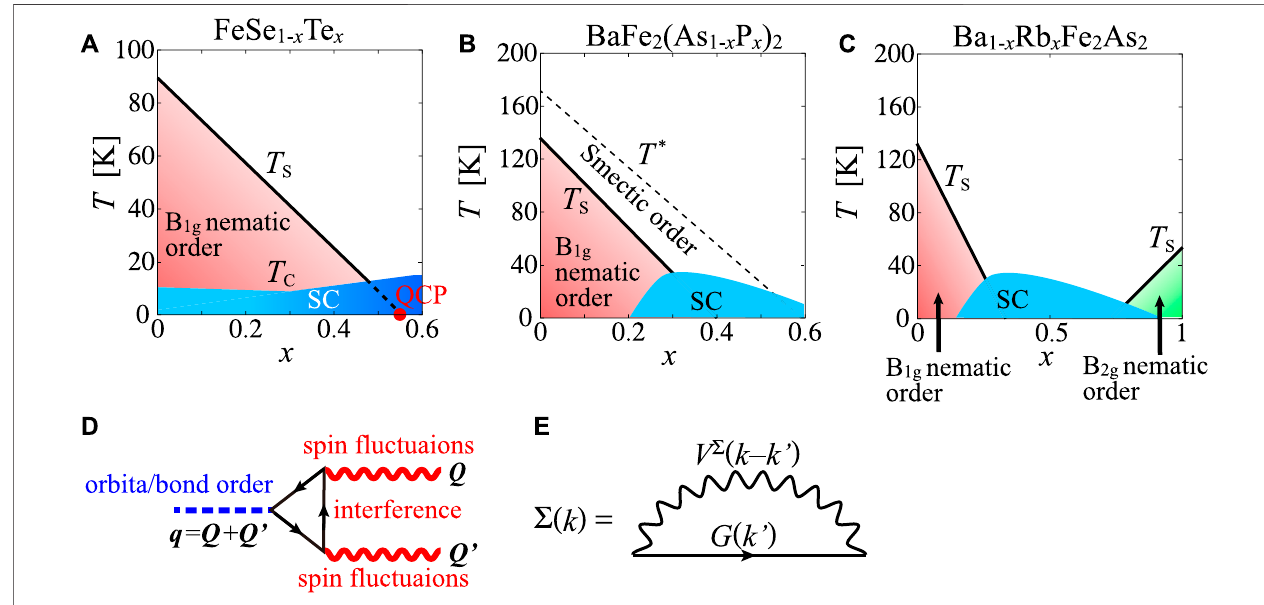
FIGURE 1 | (A) Schematic x - T phase diagram of FeSe 1 − x Te x , where T S decreases with x , and T c becomes maximum near the nematic QCP. (B) Schematic x - T phase diagram of BaFe 2 ( As 1 − x P x ) 2 , where tiny nematicity appears for T S < T < T *. We explain that “ tiny nematicity ” above T S originates from the smectic bond order in later sections. (C) Schematic x - T phase diagram of Ba 1 − x Rb x Fe 2 As 2 . The B 2 g nematic order appears for the heavily hole-doped region x > 0.5. (D) Feynman diagram of the paramagnon interference mechanism for the orbital/bond order. (E) Feynman diagram of self-energy Σ ( k ).